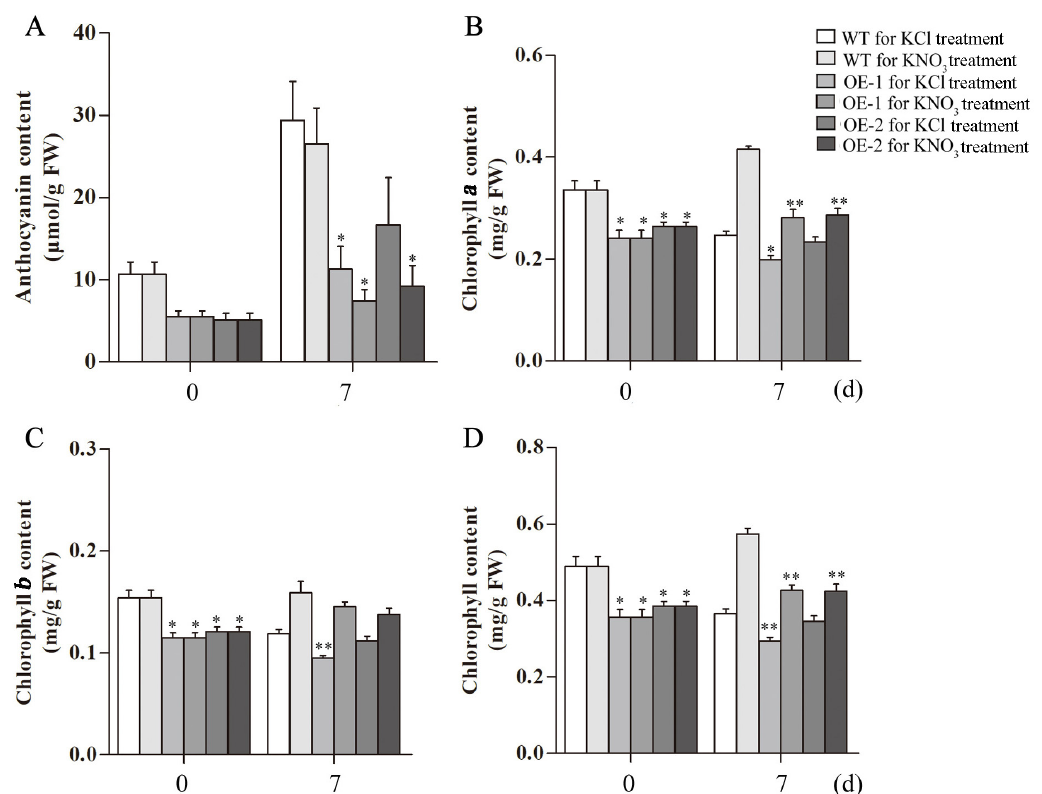
Figure 10. Analysis of anthocyanins and chlorophyll contents in WT and transgenic Arabidopsis plants hosting CsLBD39 gene under KCl and KNO 3 conditions. ( A ) The total anthocyanins contents of leaves in WT and transgenic Arabidopsis under KCl and KNO 3 conditions. ( B ) The contents of chlorophyll a ( C ) chlorophyll b , and ( D ) total chlorophyll of leaves in transgenic and WT Arabidopsis under KCl and KNO 3 conditions. The data are expressed as mean ± standard deviation of three biological replicates ( n = 3). Asterisks (*) indicate that the value is significant difference compared to the WT (* p < 0.05; ** p < 0.01).